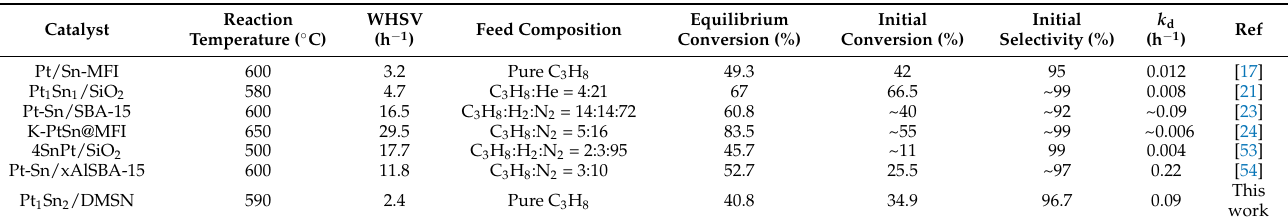
Table 2. Catalytic data of PtSn/SiO 2 catalysts used in the PDH